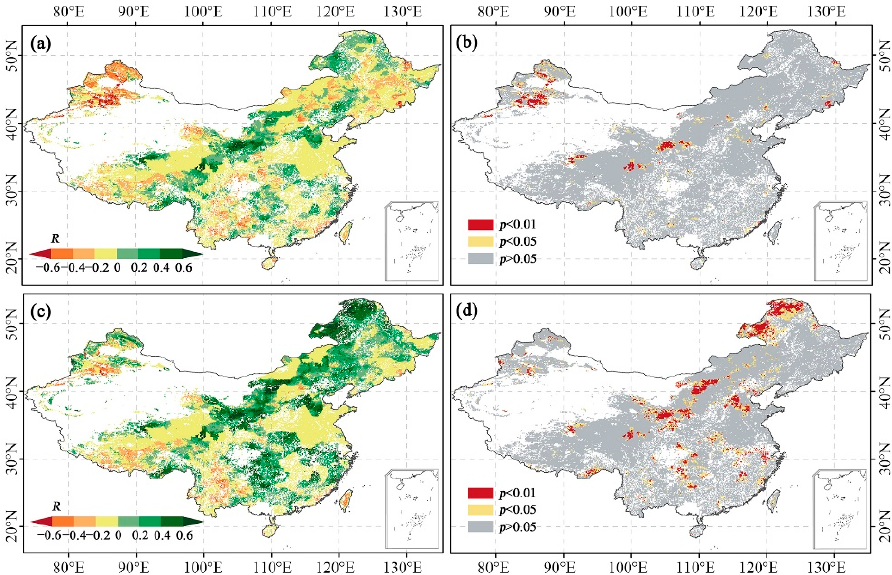
13 of 24 Figure 8. Frequency distribution of the areas with negative correlation ( R < 0) between gross primary productivity (GPP) and vapor pressure deficit (VPD) for different vegetation types (a) evergreen forests, (b) deciduous forests, (c) mixed forests, (d) woody savannas, (e) savannas, (f) grasslands, and (g) croplands under different temporal scales (annual and seasonal) across China from 2001 to 2020. 3.3. The Impact of Drought on Vegetation GPP The spatial distribution of the correlation coefficients between GPP drought_month and SPEI drought_month /VPD drought_month and the p -value are shown in Figure 9. We found that the GPP drought_month was negatively correlated with SPEI drought_month over 66.3% of the study area (Figure 9a). Among these, 5.1% showed a significant negative correlation ( p < 0.05), which indicated an inhibitory effect of drought on GPP. The area in which GPP drought_month was negatively correlated with VPD drought_month was 48.7%, with only 1.1% showing a significant negative correlation ( p < 0.05). Relative to VPD, the drought indicated by SPEI had a more severe negative impact on vegetation GPP. Furthermore, the spatial distribution showed